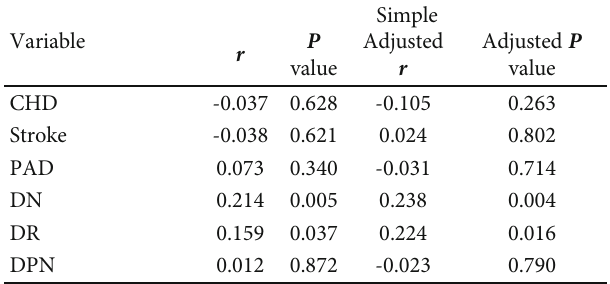
Table 2: Linear correlation analysis of variables associated with circulating omentin-1 in study